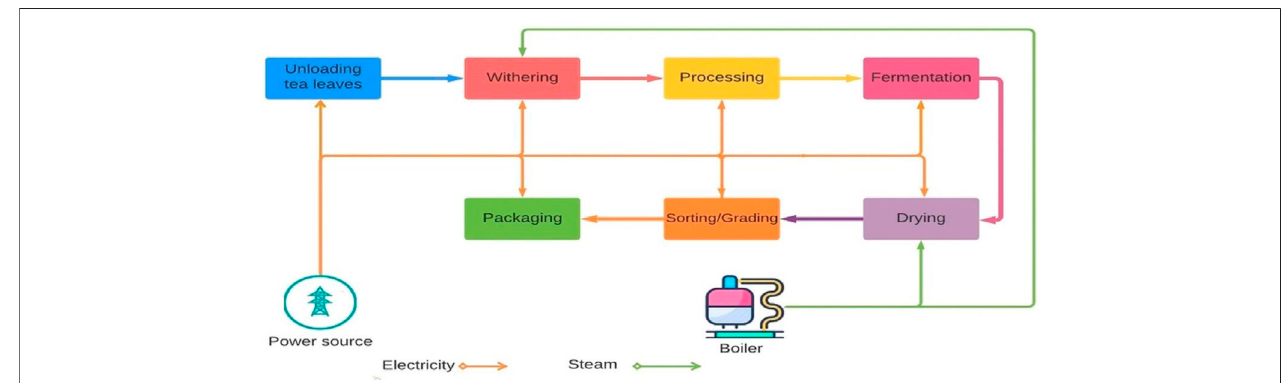
FIGURE 1 | Processing steps in tea